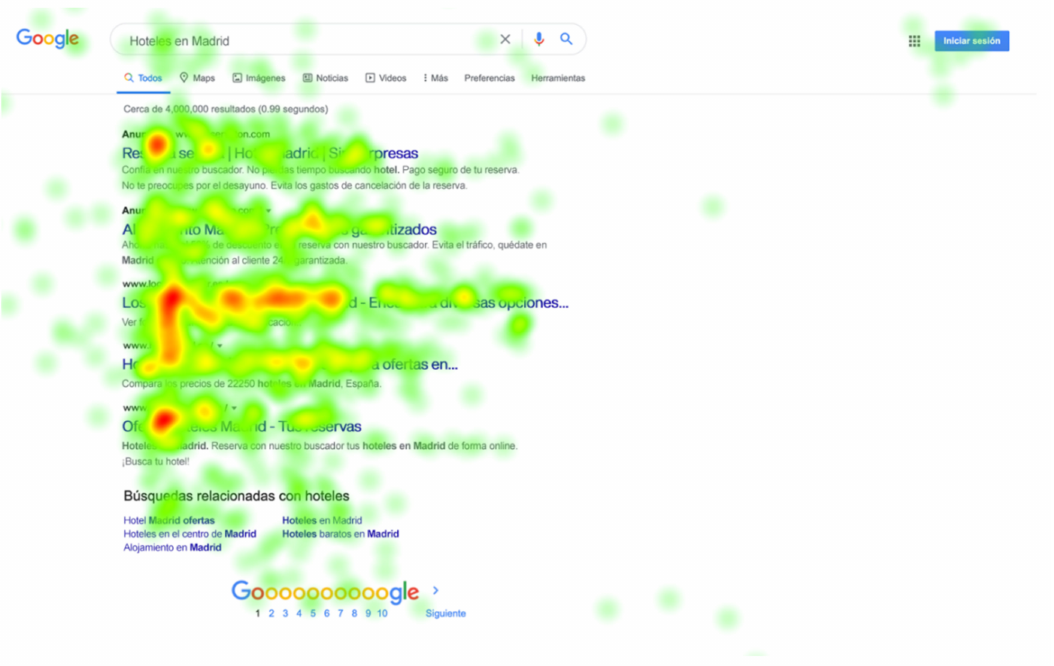
Figure 7. Heatmap for the PRE